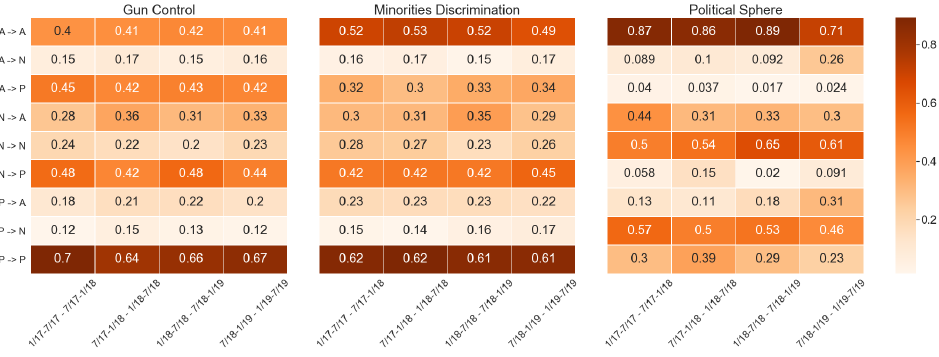
Figure 4. For each topic, transition probabilities of users’ ideology over contiguous semesters. A stands for Anti-Trump users, P for Pro-Trump ones, and N for